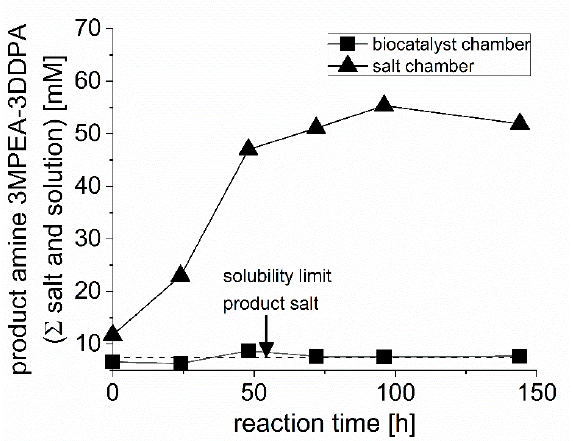
Figure 5. 3MPEA concentration curve in the chambers of the membrane reactor, 30 °C, 25 mM HEPES buffer pH 7.5, 100 mM 3MAP, 100 mM IPA-3DPPA, 100 mM additional isopropylamine and 5 mM PLP (within entire solution).